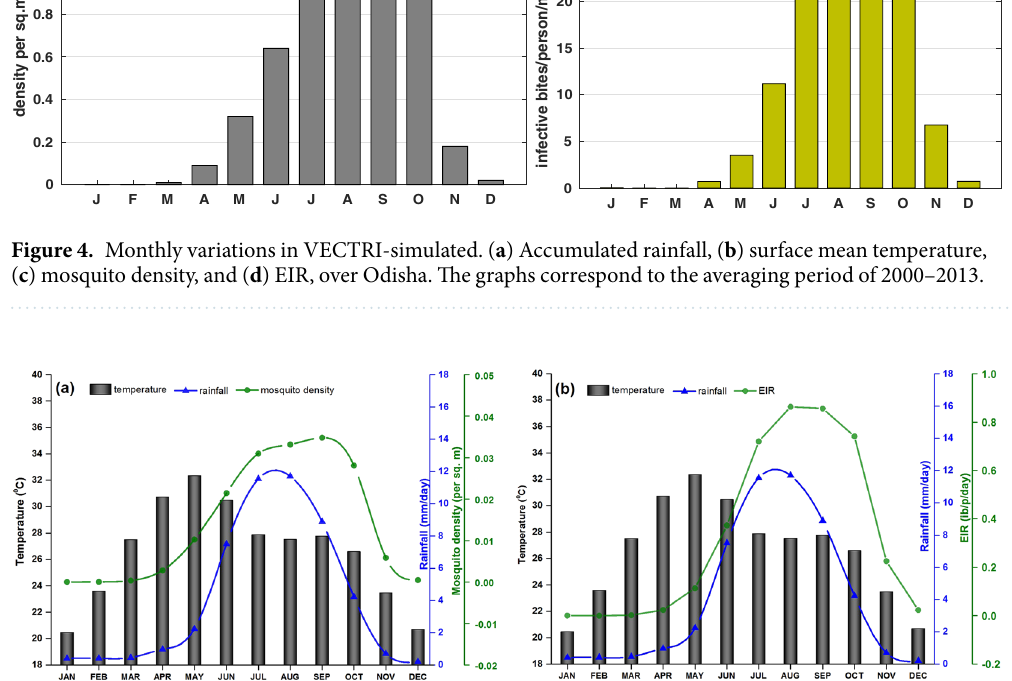
Figure 5. Graph showing the relationship between VECTRI-simulated surface mean temperature and rainfall with: ( a ) mosquito density, and ( b ) EIR, over Odisha. The graphs correspond to the averaging period of 2000–